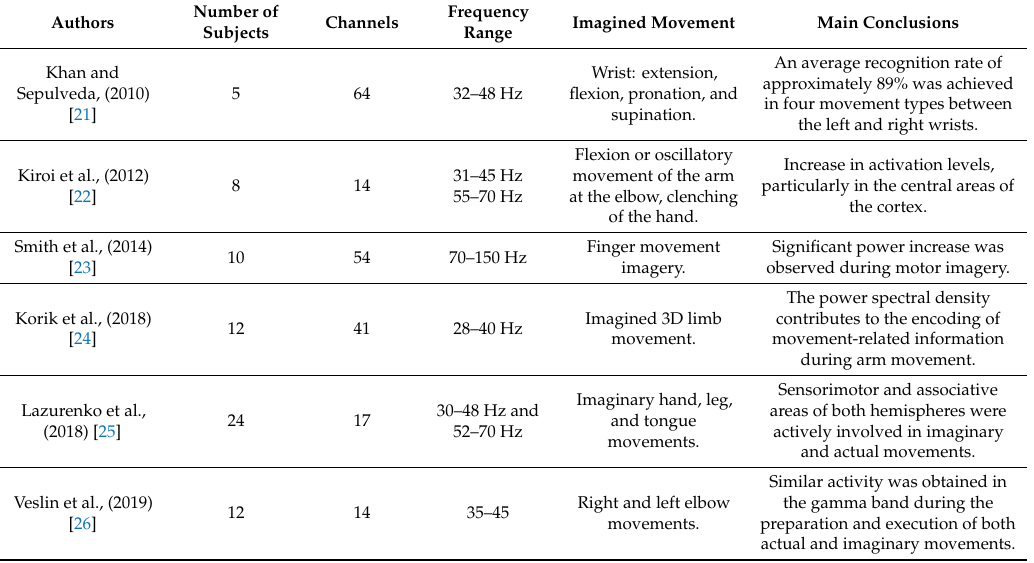
Table 1. Studies analyzing GBA non-invasively during imaginary movement using conventional EEGs.